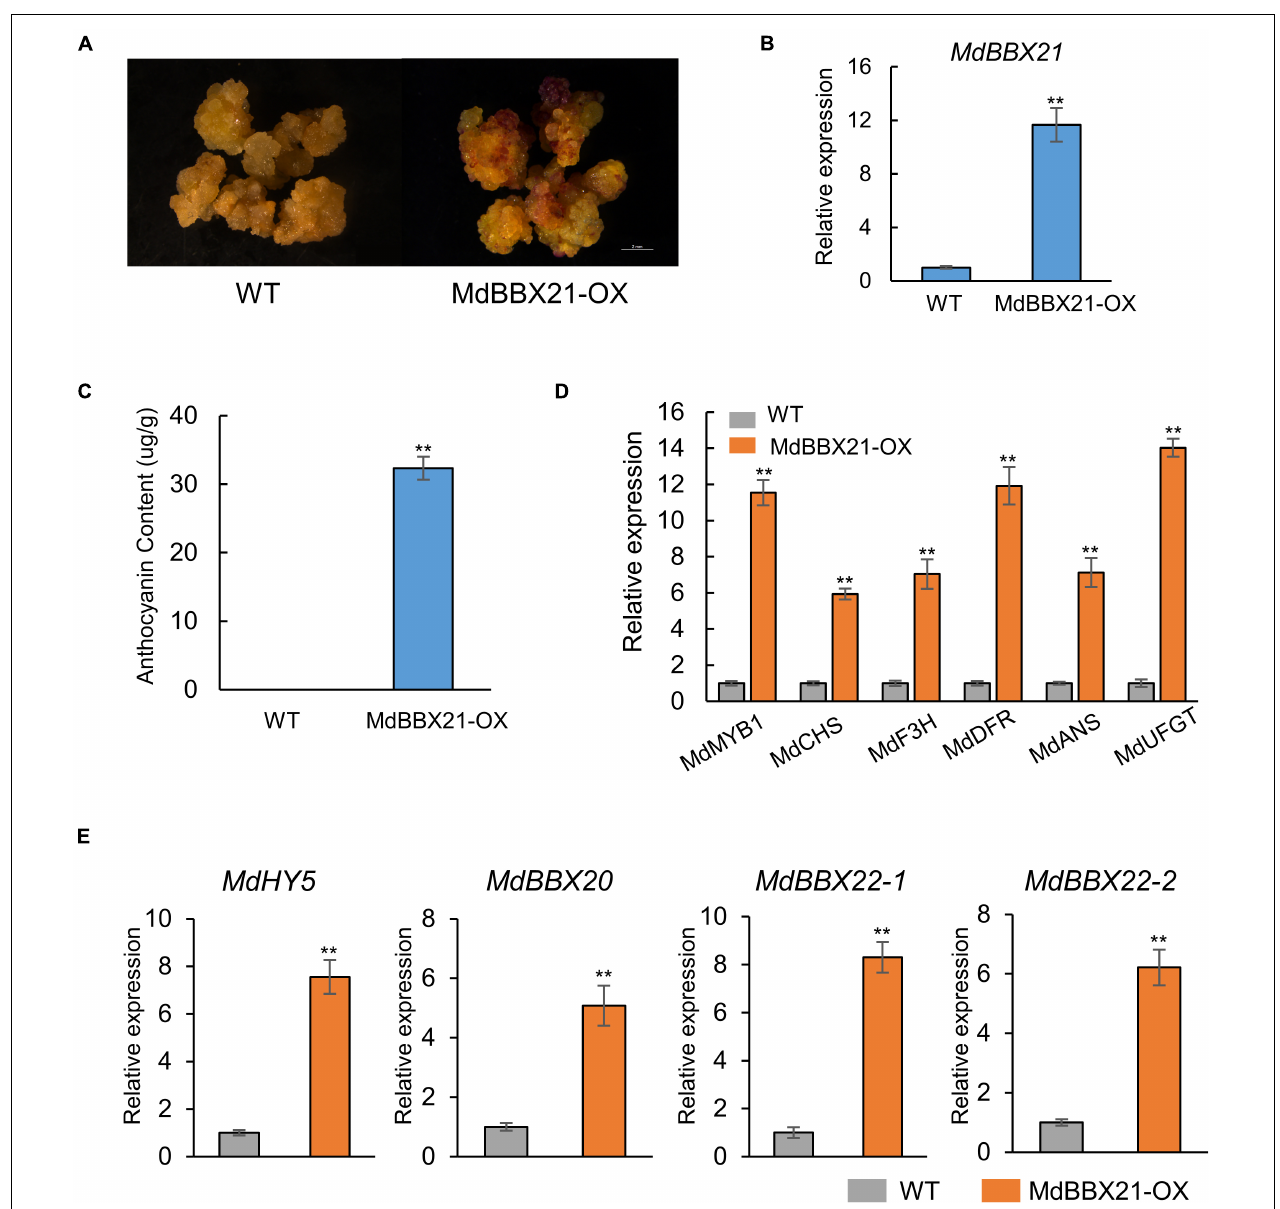
FIGURE 6 | Overexpression of MdBBX21 promotes anthocyanin accumulation in apple calli. (A) Anthocyanin accumulation phenotypes of apple calli (WT: wild-type apple calli; MdBBX21-OX: MdBBX21 overexpression apple calli). (B) MdBBX21 ’s expression level in WT and MdBBX21-OX. (C) Anthocyanin contents in WT and MdBBX21-OX. (D) The expression levels of anthocyanin biosynthesis-related genes in WT and MdBBX21-OX. (E) The expression levels of MdHY5 , MdBBX20 , and MdBBX22 - 1 / 2 in WT and MdBBX21-OX. Error bars represent the standard deviation of three biological replicates. ** P < 0.01 (Student’s t